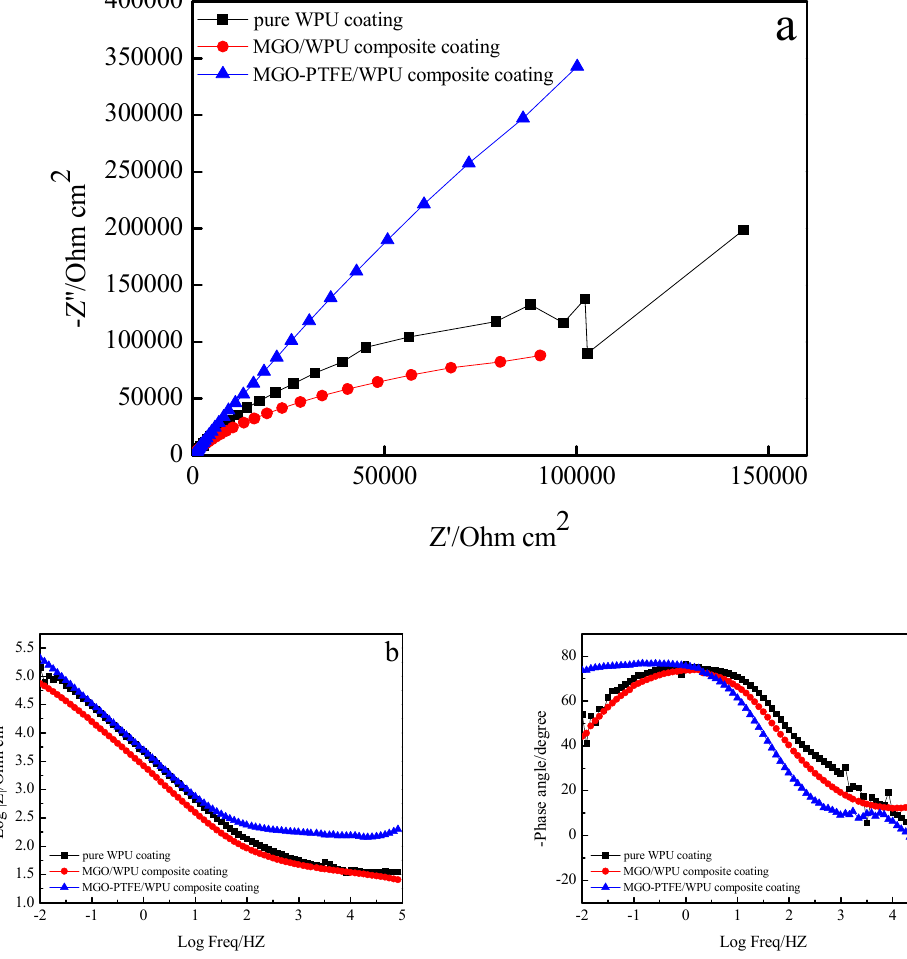
Figure 9. EIS diagrams of pure WPU coating, 0.5 wt.% MGO / WPU composite coating and 0.5 wt.% MGO-PTFE / WPU composite coating after friction, ( a ) Nyquist plot, ( b ) and ( c ) Bode plot.